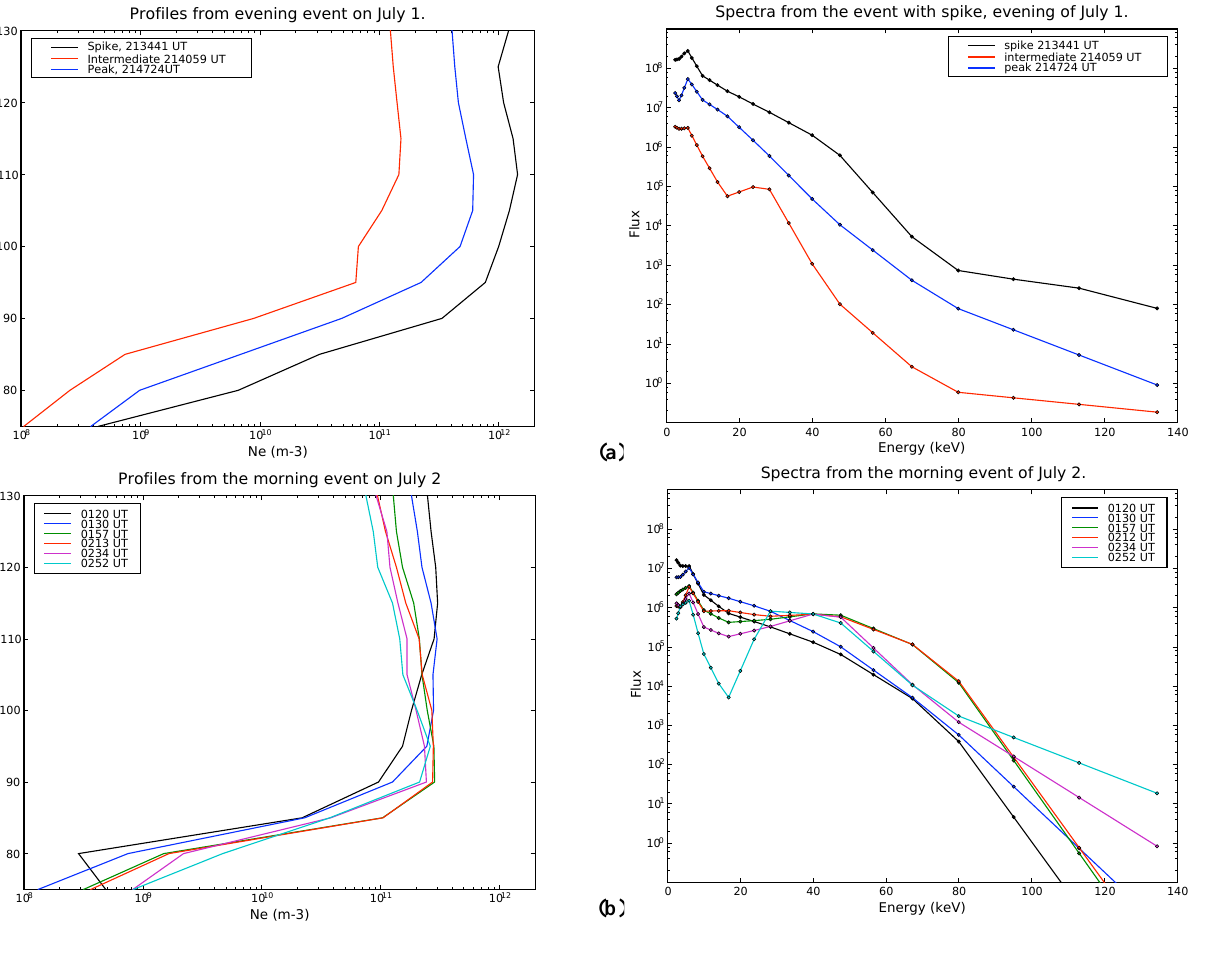
Fig. 5. (a) Profiles from the evening event on 1 July. (b) Profiles from the morning event on July 2, corrected for solar EUV contri- butions.